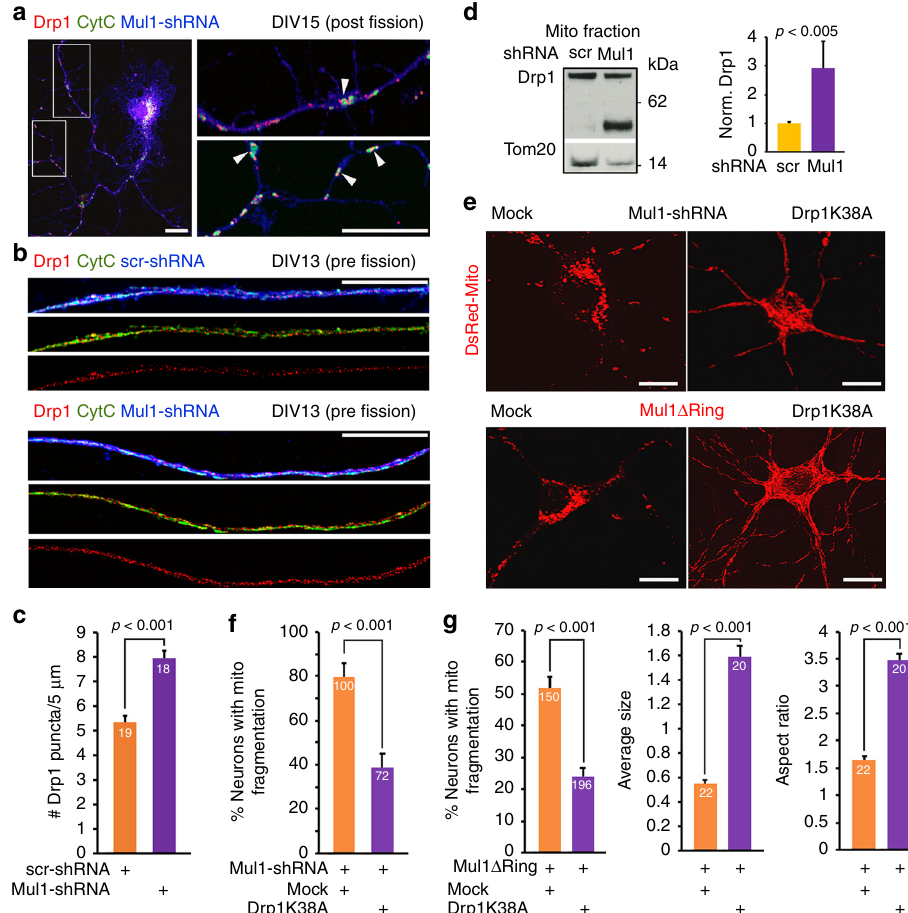
Fig. 7 Drp1 mediates second phasic mitochondrial fragmentation. a – c Representative images showing the targeting of Drp1 to fragmented mitochondria in Mul1-de fi cient neurons. Cortical neurons at DIV7-8 were co-transfected with GFP and Mul1-shRNA or scr-shRNA, followed by co-immunostaining of Drp1 (red) and cyto c (green) at DIV14-15 ( a ) or DIV13 ( b ) (pre- fi ssion status). GFP (pseudo blue) was used to trace transfected neurons. Arrows point to Drp1 puncta on fragmented mitochondria ( a ). Average number of Drp1 puncta per 5 µ m mitochondrial length was measured from the total number of mitochondria (scr-shRNA, n = 518; Mul1-shRNA, n = 423) in the total number of neurons indicated in the bars. d A representative immunoblot showing an increased Drp1 translocation to mitochondria in Mul1 depleted neurons. Equal amounts (15 µ g) of mitochondrial fractions were sequentially immunoblotted on the same membrane with each antibody after stripping. Note that a shorter Drp1 isoform (~58 kDa) was recruited into mitochondrial fraction in Mul1- de fi cient neurons. e – g Drp1-dependent mitochondrial fragmentation in Mul1-de fi cient neurons. Cortical neurons at DIV7-8 were co-transfected with Mul1- shRNA, DsRed-Mito and Myc-tagged plasmid (Mock) or Drp1K38A, or co-transfected with Flag-tagged Mul1 Δ Ring and Mock or Drp1K38A, followed by fi xation and imaging at DIV14-15. Note that expressing Drp1K38A locks mitochondrial in hyperfusion status in the late stage of Mul1-de fi cient neurons. All data were analyzed from the total number of neurons indicated in the bars in three experiments and are expressed as mean ± s.e.m. Unpaired Student ’ s t -test. Scale Bars: 10 μ